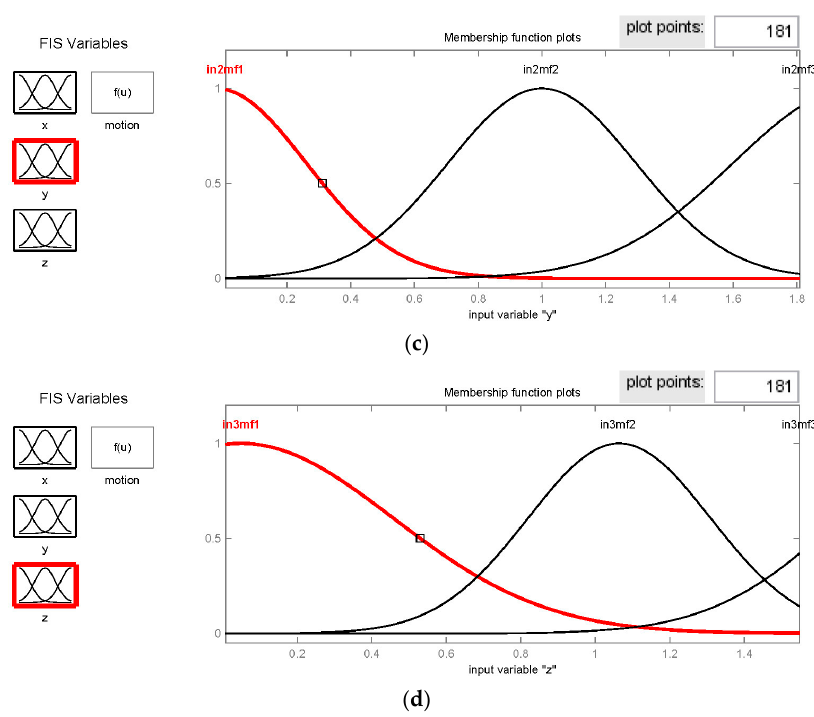
Figure 6. Membership functions (MFs) in the fuzzy sets of the initial and trained FISs for recognizing the motions of walk and run : ( a ) identical MFs of three features for the initial FIS; ( b ) adapted MFs of feature x; ( c ) adapted MFs of feature y; and ( d ) adapted MFs of feature z for the trained FIS; where, in1mf1 represents the first membership function of the first input feature (i.e., x), and is similar for three input features. The ( x , y , z ) means three components of the standard deviation of acceleration by the thigh ( σ gB ) for this example. Table 4. Antecedent parameters corresponding to the ANFIS modeling and recognition rate of the assigned dynamic motions estimated by the trained FIS.